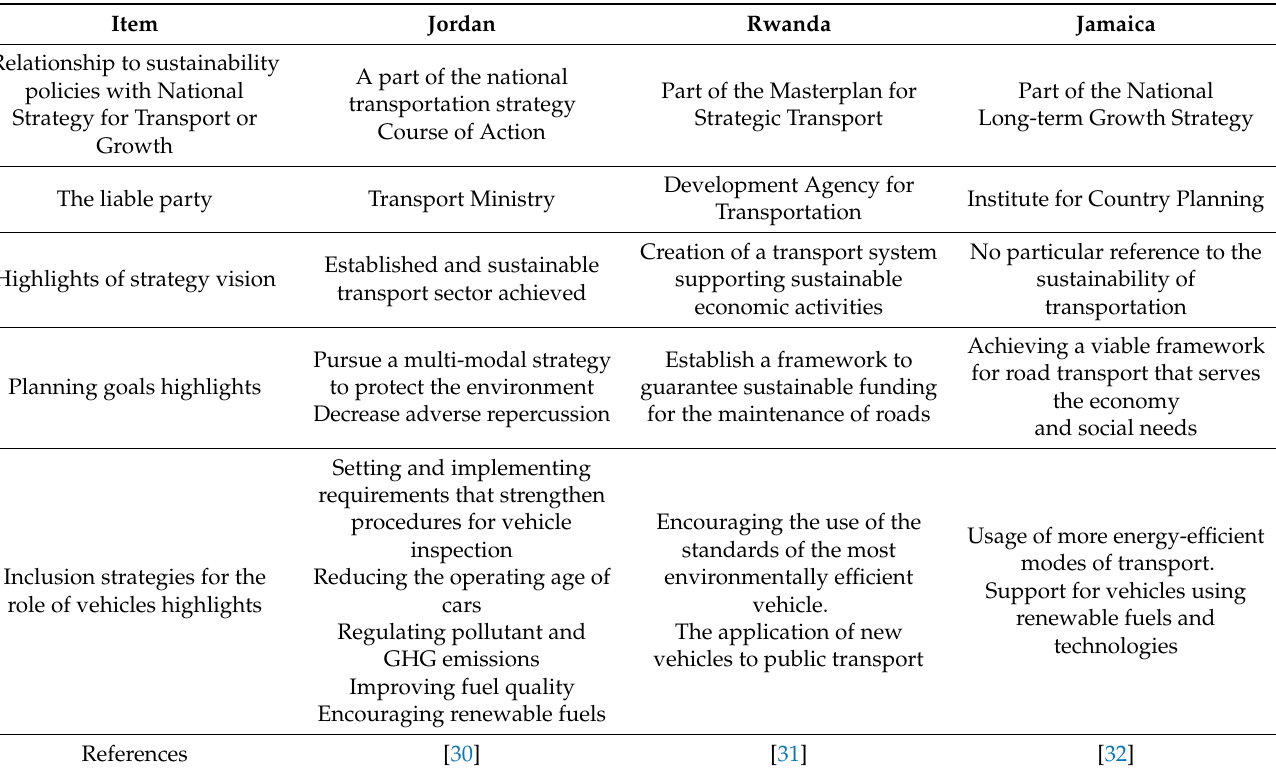
Table 1. Summary of the case studies on sustainable transportation policies by the government for Jordan, Rwanda, and